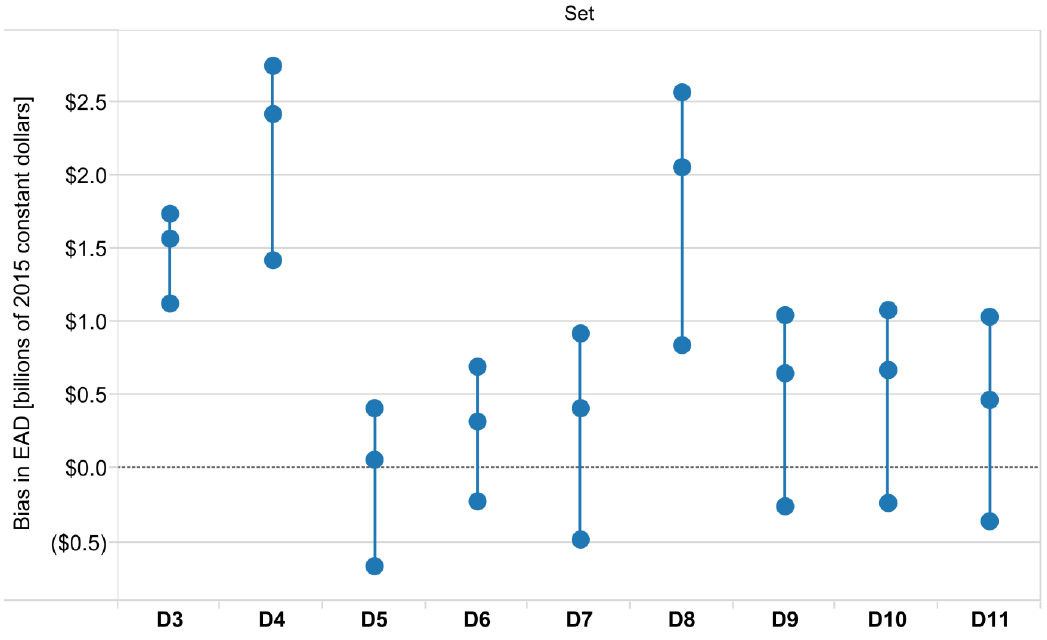
Figure 12. Coastwide bias in terms of expected annual damage (billions of 2010 US dollars).